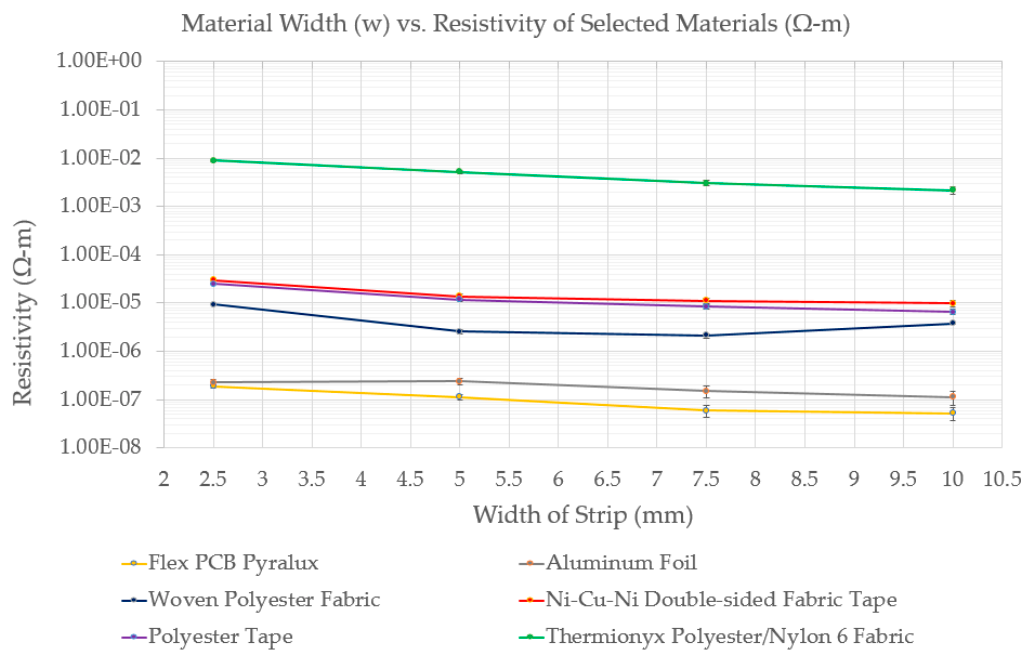
Figure A2. Resistivity of conductive fabrics. Standard-sized strips of each conductive material measured for electrical resistance at different widths.